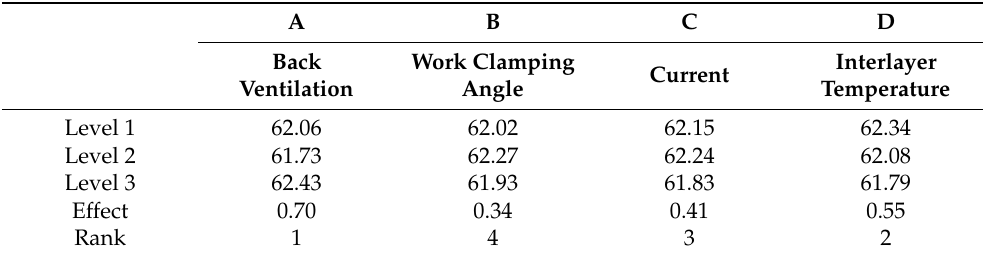
Table 9. S / N ratio factor response table of Vickers hardness value test experiment of UNS31803 duplex stainless steel in L9 direct cross